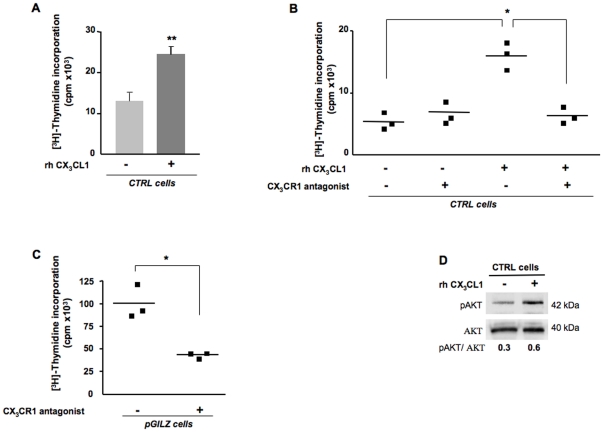
CX3CL1 promotes the proliferation of BG1 cells.(A–C) Proliferation was measured by [3H]-thymidine incorporation (A) in CTRL cells incubated with or without 10 ng/ml rhCX3CL1 for 24 h, 9 independent experiments. Histograms represent means ± SEM, paired t test, **
P<0.001; (B) in CTRL cells incubated with or without 10 ng/ml rhCX3CL1 for 24 h, in the presence or absence of 10 µg/ml CX3CR1 antagonist; each symbol represents an individual sample run in triplicate, lines represent mean values, * P<0.05, t test, one representative experiment out of 3; (C) in pGILZ cells with and without treatment with 10 µg/ml CX3CR1 antagonist replaced every 24 h for 72 h, each symbol represents an individual sample run in triplicates, lines represent mean values, * P<0.05, t test, one representative experiment out of 3. (D) Total cellular protein extracts of CTRL cells cultured in the presence and absence of 10 ng/ml rhCX3CL1 analyzed by western blotting with specific Abs. pAKT levels were quantified by densitometry, with normalization against the signal for total AKT. Results are expressed as pAKT/AKT ratios. One blot, representative of three carried out, is shown.